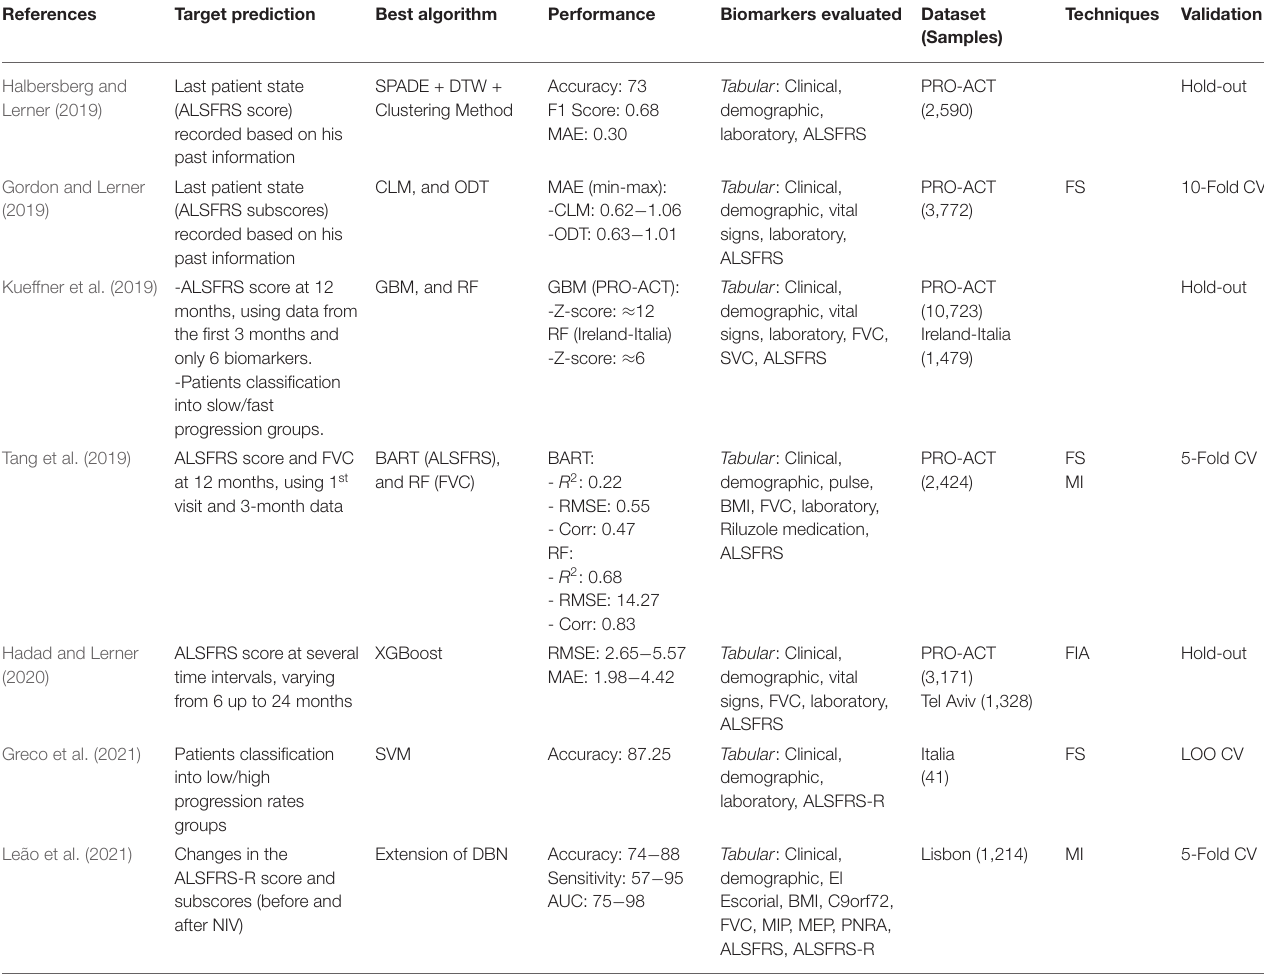
TABLE 6 | Overview of ML approaches on disease